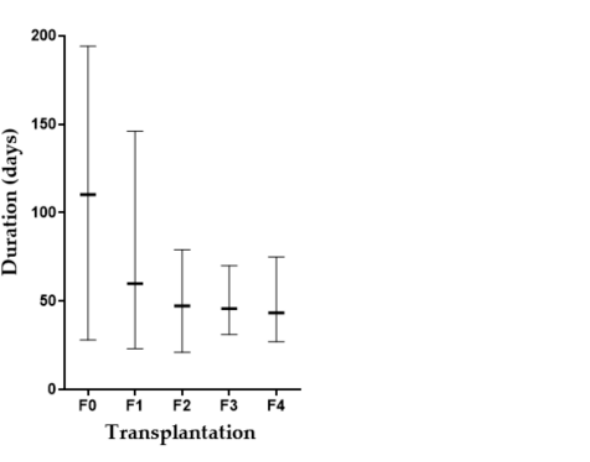
Figure 2. Comparison of PDX growth duration during serial transplantation. Bar indicates the longest to the shortest duration in each generation and - indicates a mean duration.